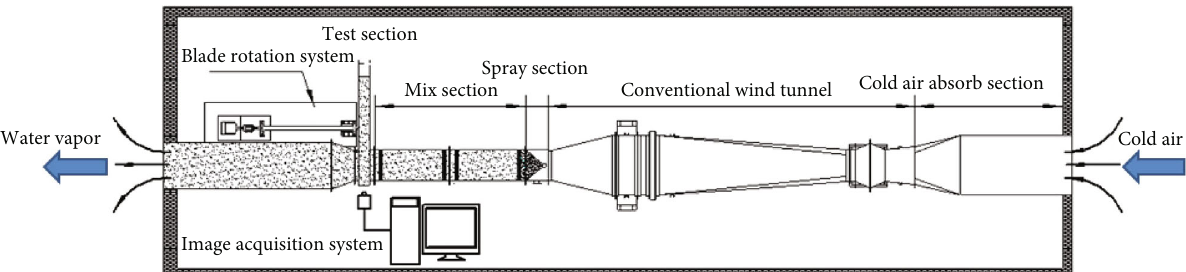
Figure 1: Schematic diagram of the icing wind tunnel test system.